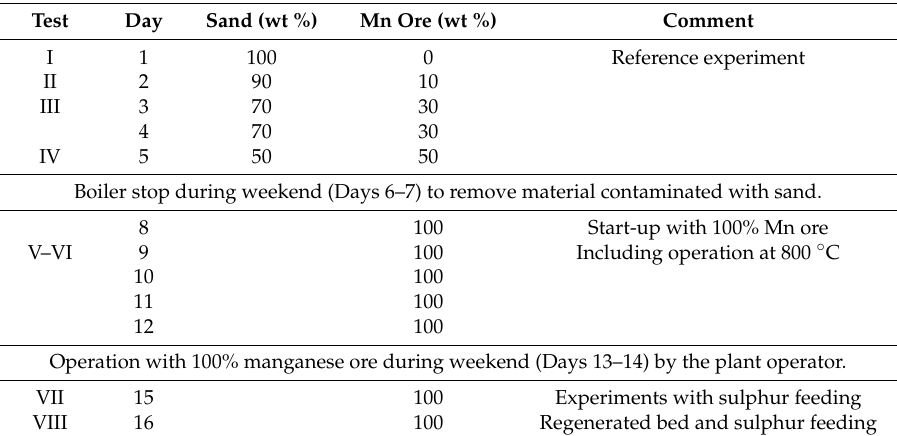
Table 3. Overview of the experimental campaign in Chalmers Research